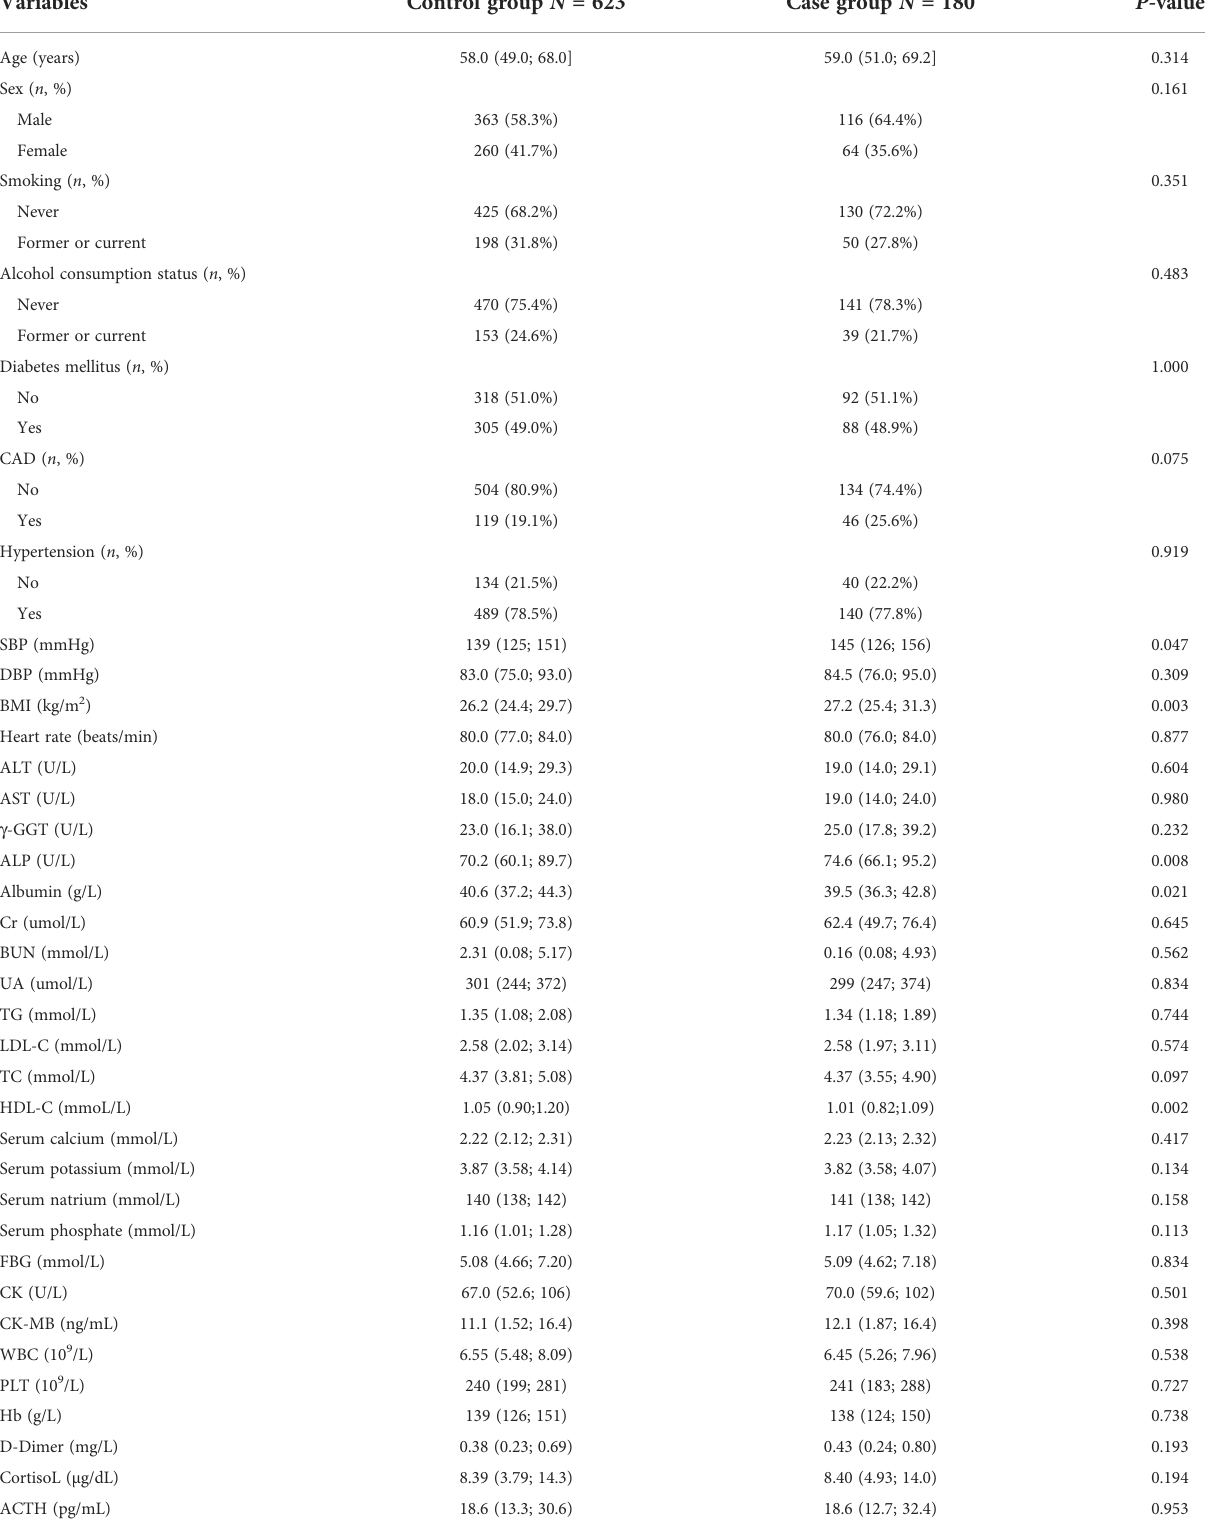
TABLE 1 Baseline characteristics of the case group and control